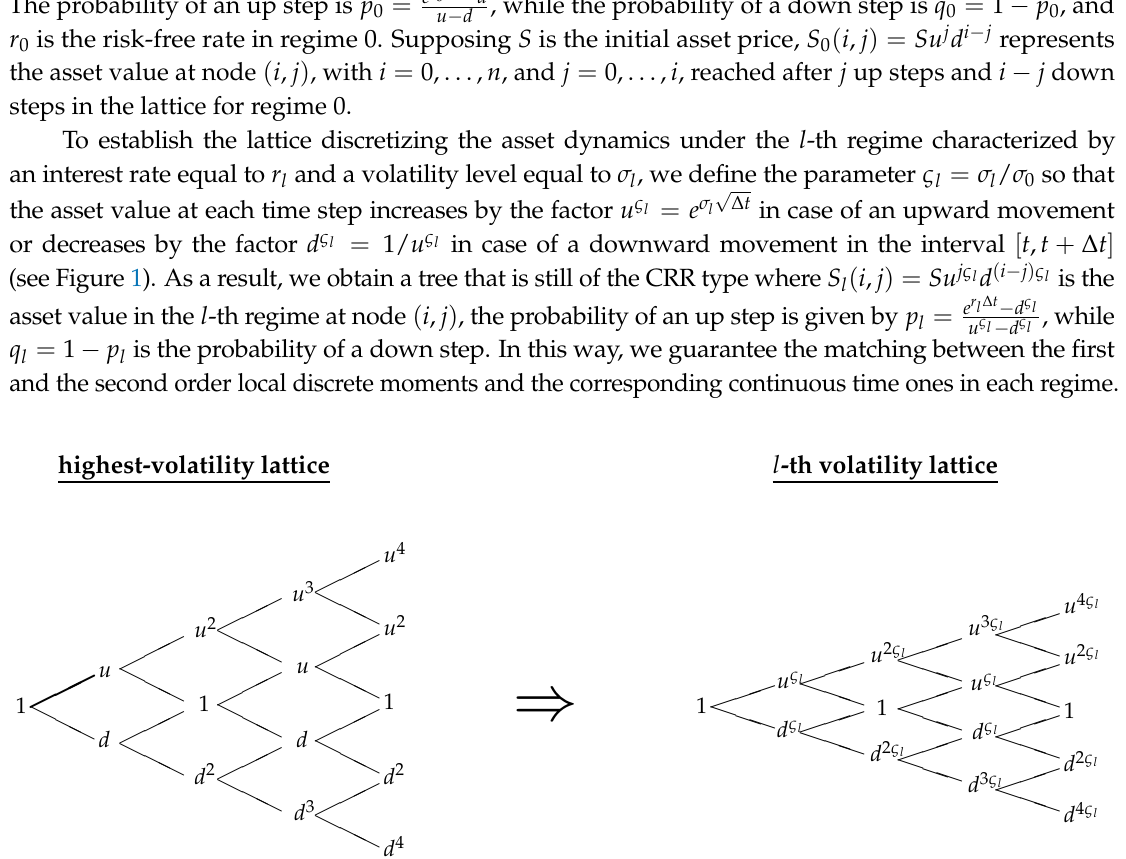
Figure 1. The one-dimensional Cox et al. (1979) (CRR) lattice in the l -th volatility regime obtained as a transformation of the CRR lattice parameters in regime 0. For the sake of simplicity, we set S =